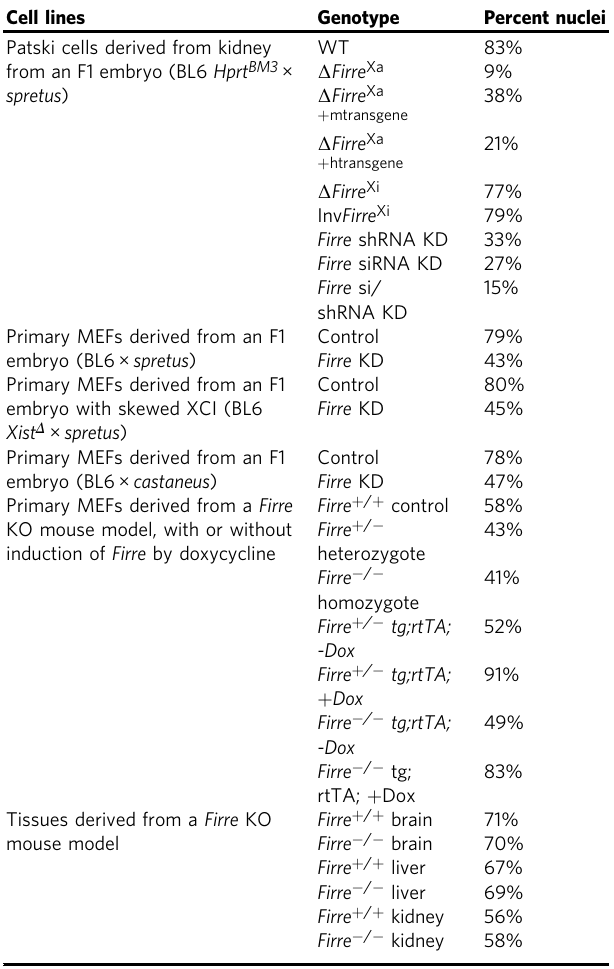
Table 1 Percentages of nuclei with a H3K27me3 cluster on the